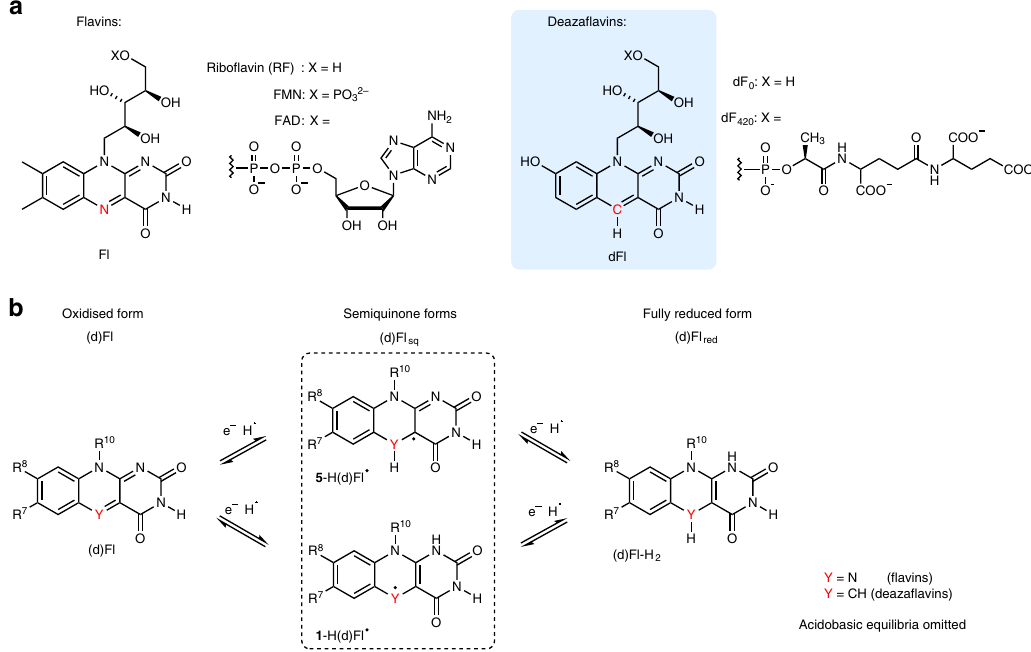
Fig. 1 Flavins, deaza fl avins, and their redox forms. a Structure of fl avin and deaza fl avin cofactors. b Redox states of fl avins and deaza fl avins. In contrast to fl avins, semiquinone deaza fl avins are untypical intermediates in redox